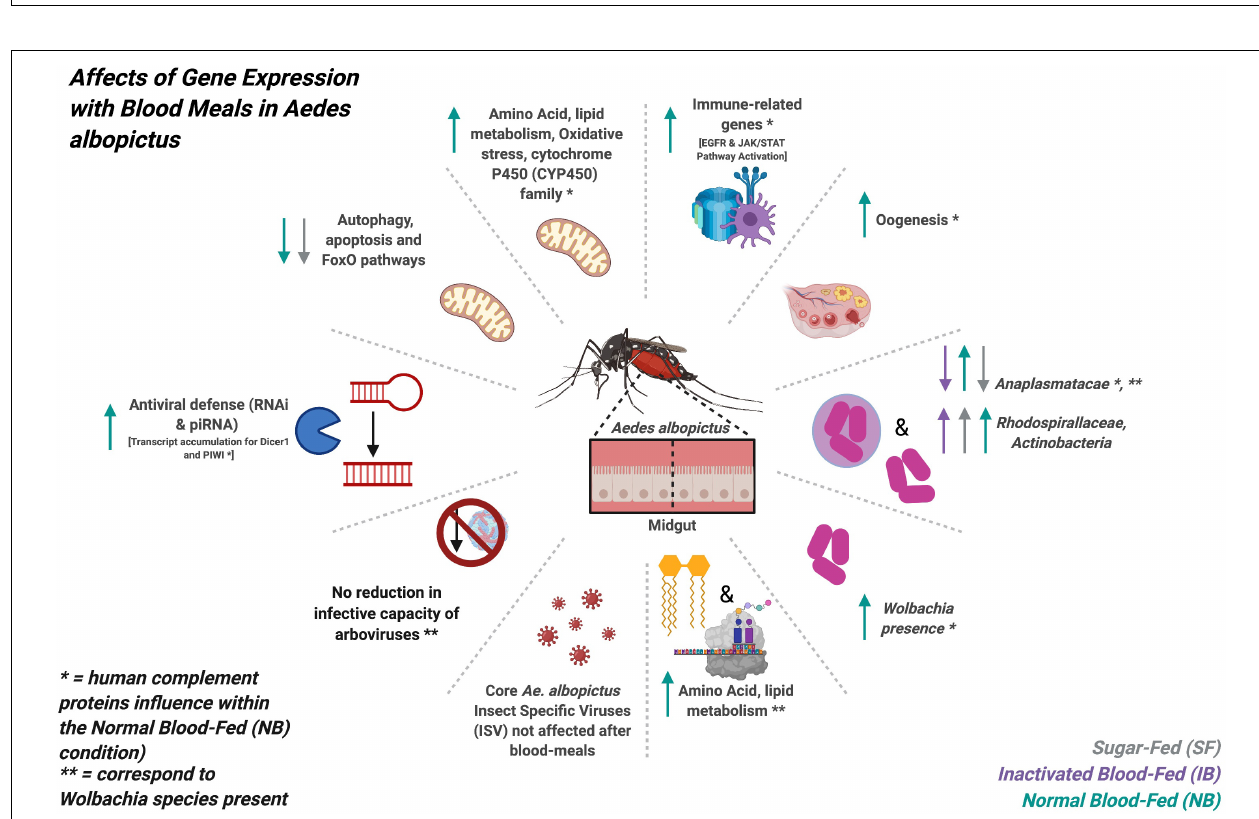
FIGURE 10 | Graphic summary of the main findings obtained in the transcriptome expression and microbiome changes of Ae. albopictus after feeding with sugar, heat-inactivated, and normal blood.